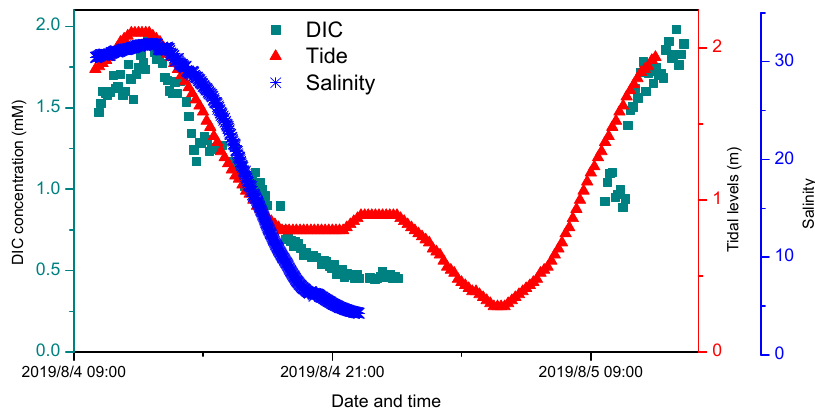
Figure 6. Time series of DIC, salinity and tidal height determined during the observation in Kuala Terengganu on 4–5 August 2019 .